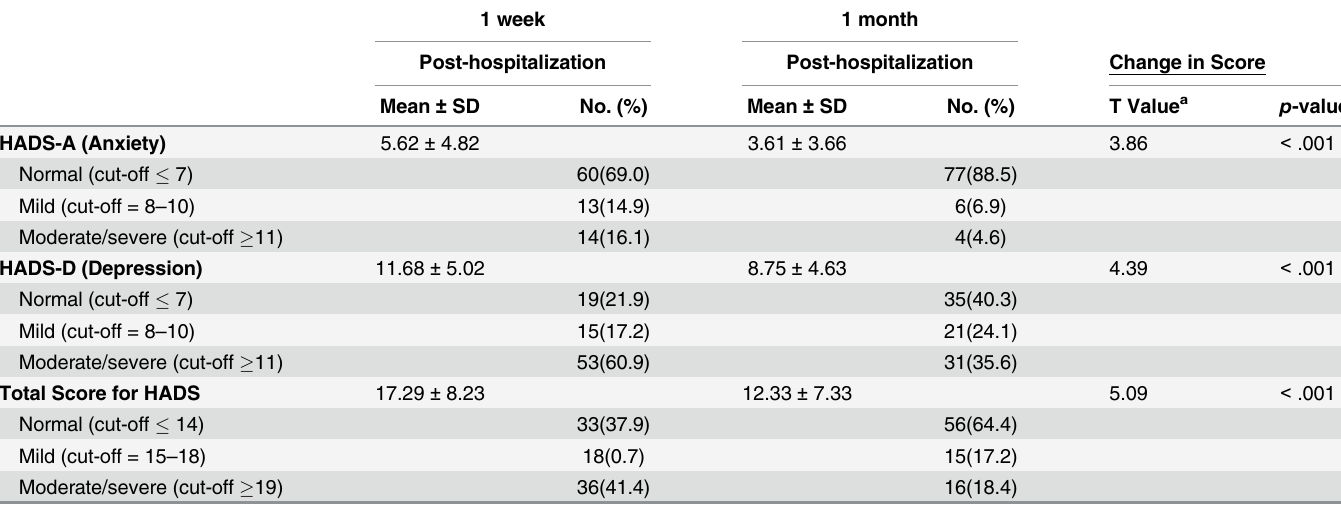
older, had a lengthier hospitalization, had poorer heart function, or had anxiety and depres- sion. At 1 month post-hospitalization a small positive correlation remained for sleep quality and age ( r = .28, p < .01). In addition, there was a positive correlation with NYHA class ( r = .38, p < .01), anxiety ( r = .54, p < .01) and depression ( r = .74, p < .01); in other words, greater Table 4. HADS scores: 1 week and 1 month post-hospitalization and the change in score at 1 month ( n = 87). 1 week